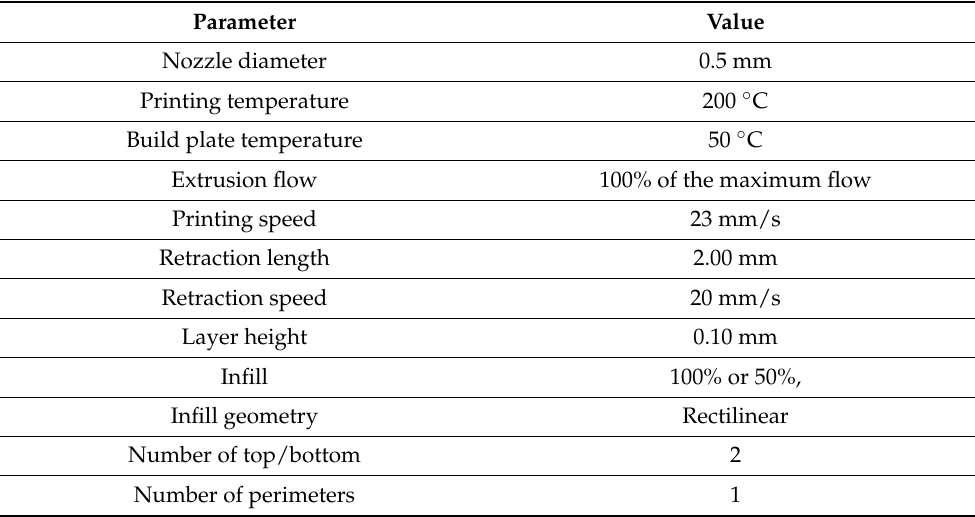
Table 1. Operating parameters set for the PVA-based formulation. Parameter Value Nozzle diameter 0.5 mm Printing temperature 200 ◦ C Build plate temperature 50 ◦ C Extrusion flow 100% of the maximum flow Printing speed 23 mm/s 2.00